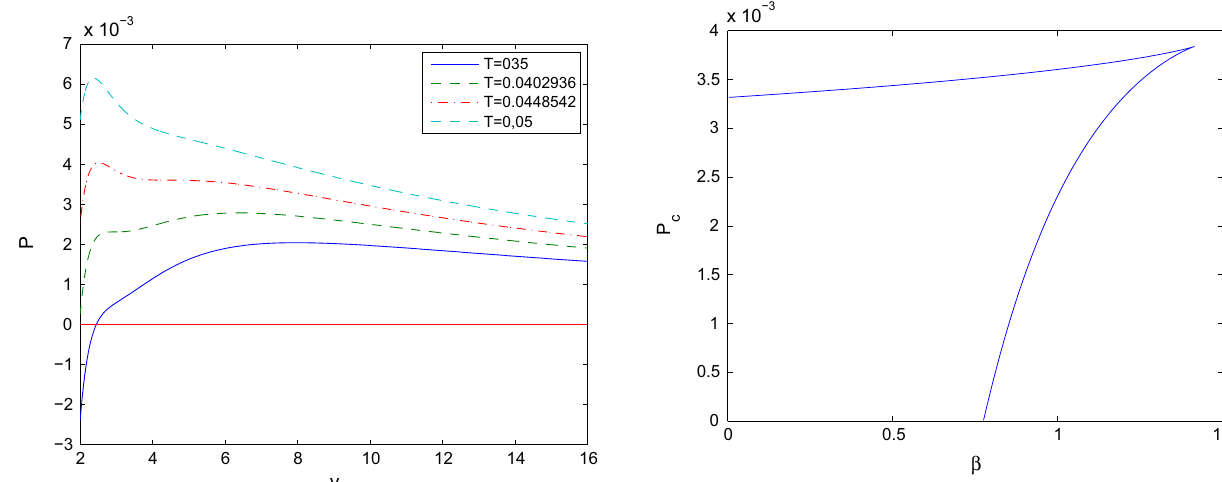
Fig. 7 The plot of the function P vs v at q m = β = 1 for T = 1 , 2 , 3 and 4